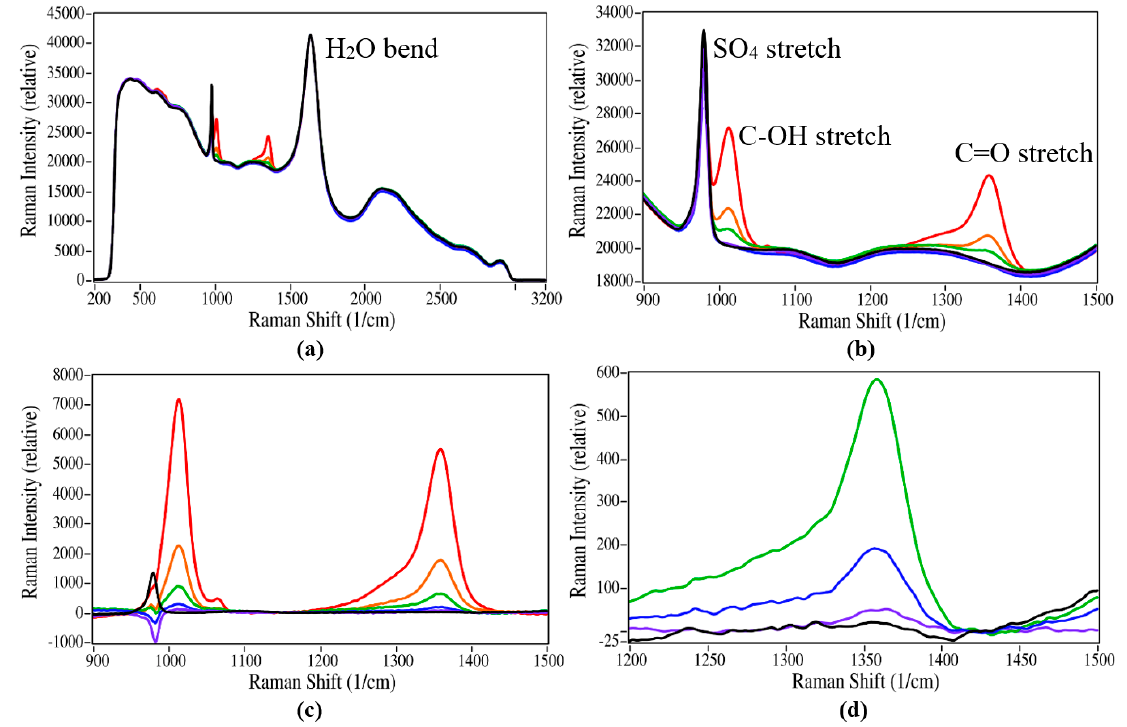
Figure 1. Raman spectra of 2650 ppm sulfate in HPLC water plus 10,000 (red), 3000 (orange), 1000 (green), 300 (blue), 100 (purple) and 30 ppm HCO 3 − (black). ( a ) Full spectra, ( b ) expanded view of sulfate and HCO 3 − peaks, ( c ) subtraction of sulfate in water spectrum from all samples by factors of 0.99 to 1.02 with the baseline set to zero at 1415 cm − 1 , and ( d ) 1000 (green), 300 (blue), 100 (purple) and 30 ppm HCO 3 − (black) spectra fit with a 3rd-order 19-point smooth. Conditions: 1 cm quartz cuvette, 90° collection geometry, flat and concave mirrors, 1.5 W at 532 nm, 240 2-sec integration scans averaged (8 min for 10,000, 3000, and 1000 ppm, 16 min for 300, 100 and 30 ppm HCO 3 − ).